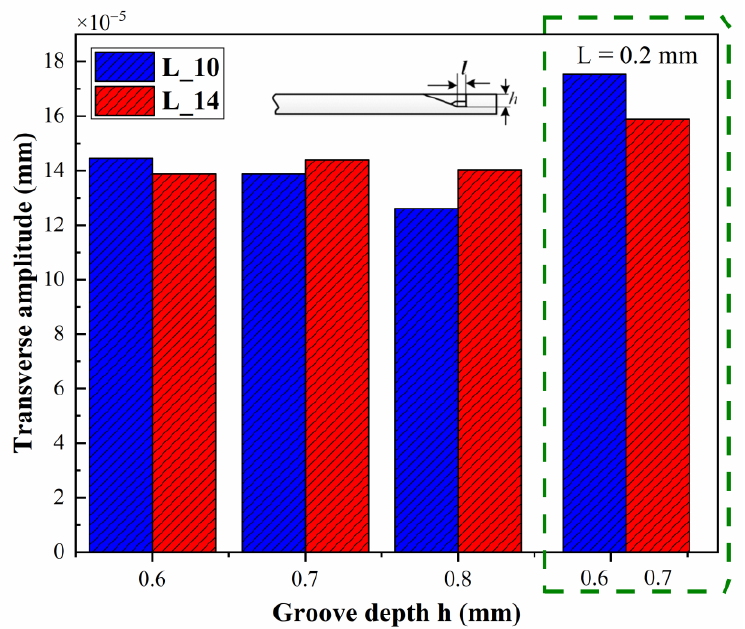
Figure 14. Transverse amplitudes with different lengths of end-effort, groove depth and extended groove length.